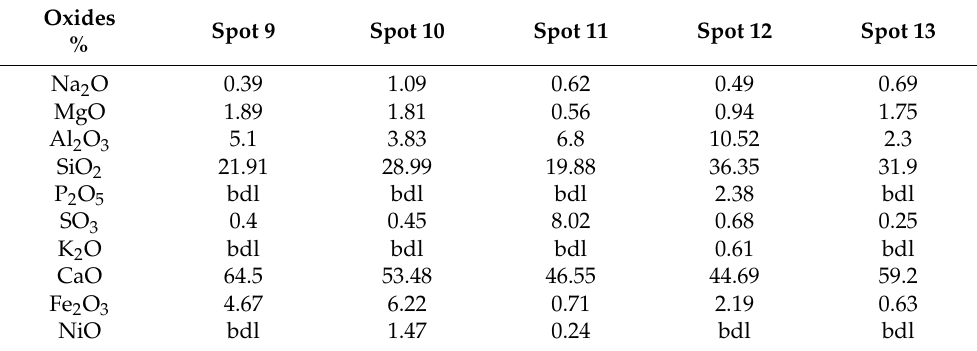
Table 8. Microchemical spot analyses (spot 9–13) of binder areas of bedding mortars from the Trebbio castle tower (Mugello, Florence).